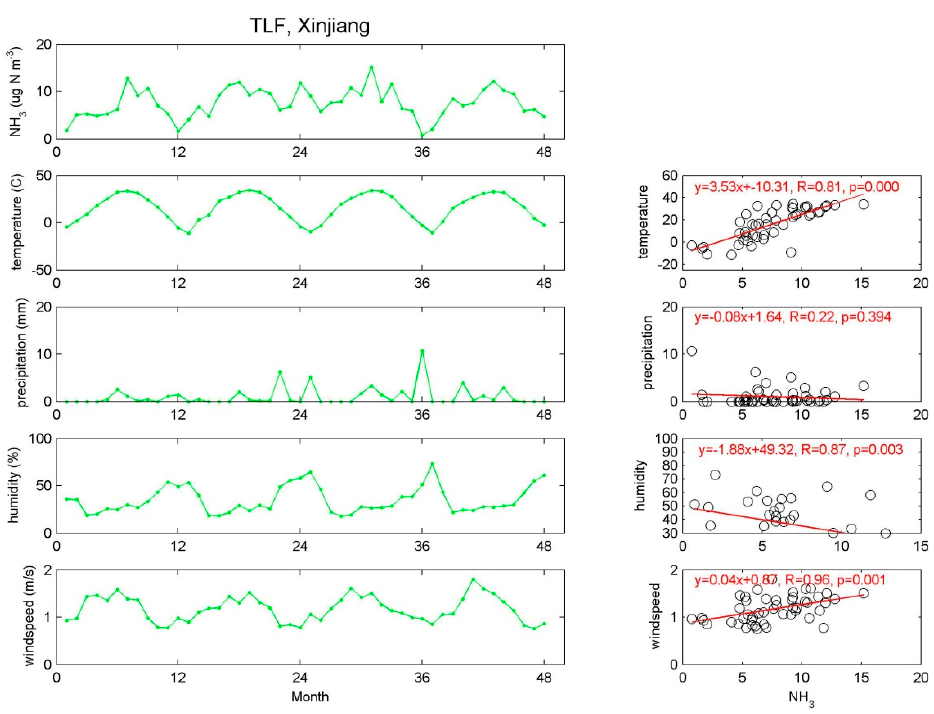
Figure A5. The seasonal variations of ground NH 3 concentrations (µg N m − 3 ), temperature (°C), precipitation (mm), humidity (%), and wind speed (m/s) at TLF from January 2010 to December 2013 (0–12, 2010; 13–24, 2011; 25–36, 2012; 37–48, 2013).